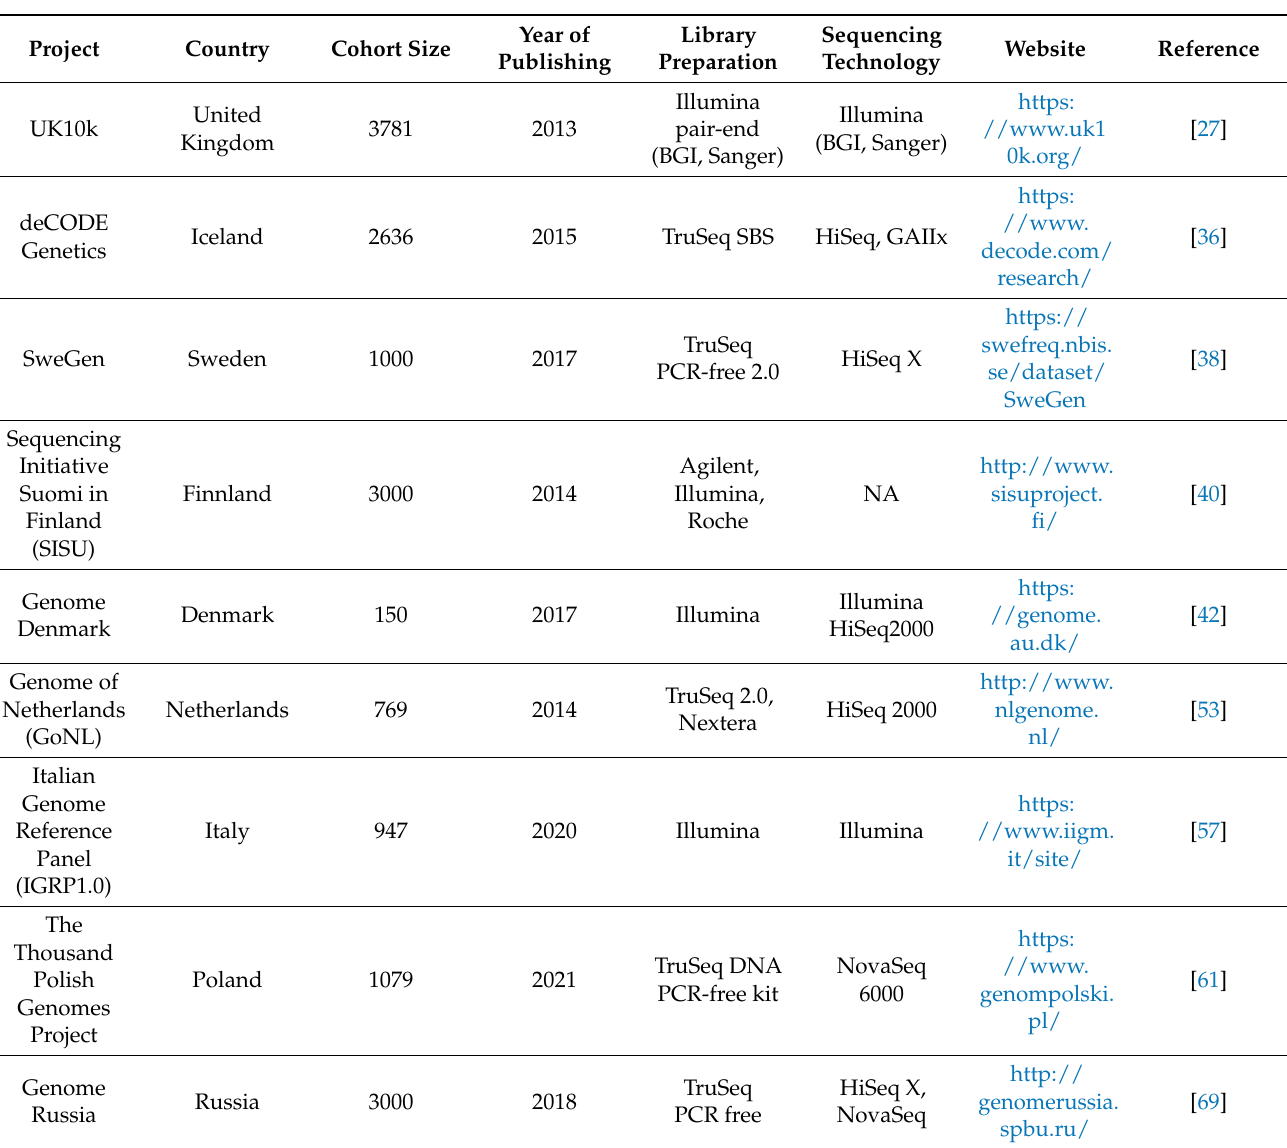
Table 1. Overview of basic characterizes of UK or European national genome projects with published scientific